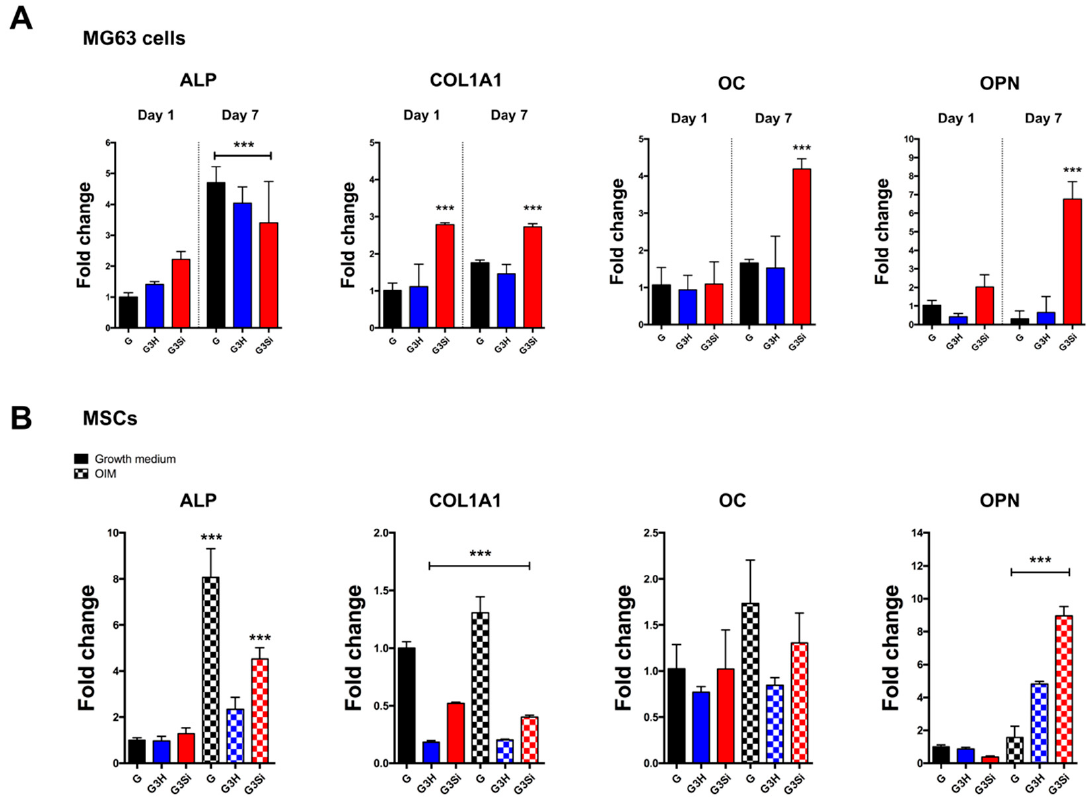
Figure 5. Gene expression of osteogenic markers in cell-laden GelMA composite hydrogels. ( A ) The expressions of alkaline phosphatase (ALP), collagen type 1, alpha 1 (COL1A1), osteocalcin (OC), and osteopontin (OPN) in MG63 cell-laden composite hydrogels were quantified by qPCR on day 1 and day 7. Fold change was normalized to the day 1 GelMA group. ( B ) Four osteogenic markers in MSCs laden composite hydrogels were quantified by qPCR on day 7. MSCs were cultured with growth medium or osteogenic induction medium. Gene expression was normalized to the GelMA group with growth medium. G: 15% GelMA, G3H: 15% GelMA with 3% HAp, G3Si: 15% GelMA with 3% Si-HAp. *** p < 0.01.